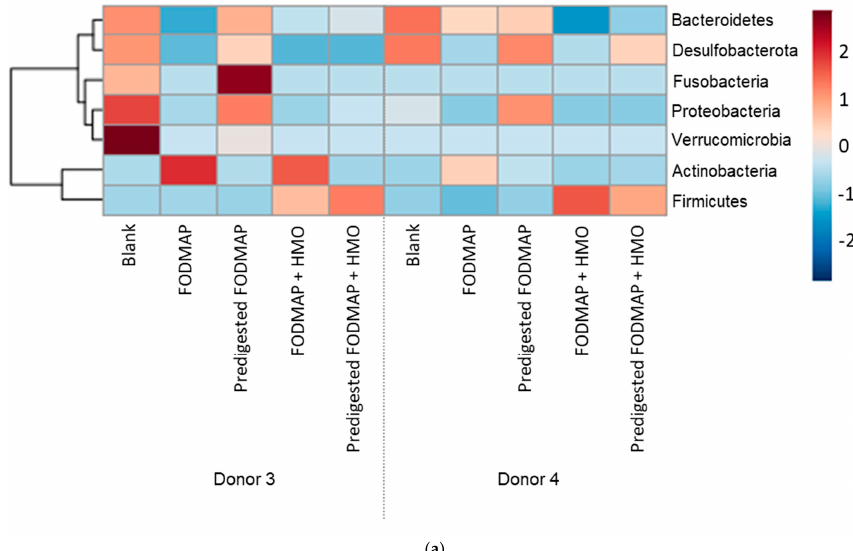
Figure 6. Changes in total SCFA, propionate, acetate, and butyrate in the QuintSHIME ® model. At the end of the treatment period (day 10), total SCFA, propionate, acetate, and butyrate production were quantified (n = 2 for each donor). Different letters represent statistically significant differences between the different test conditions ( p < 0.05). FODMAP = fermentable oligosaccharides, disaccharides, monosaccharides, and polyols; HMO = human milk oligosaccharide; SCFA = short-chain fatty acid; SHIME = simulator of the human intestinal microbial ecosystem.